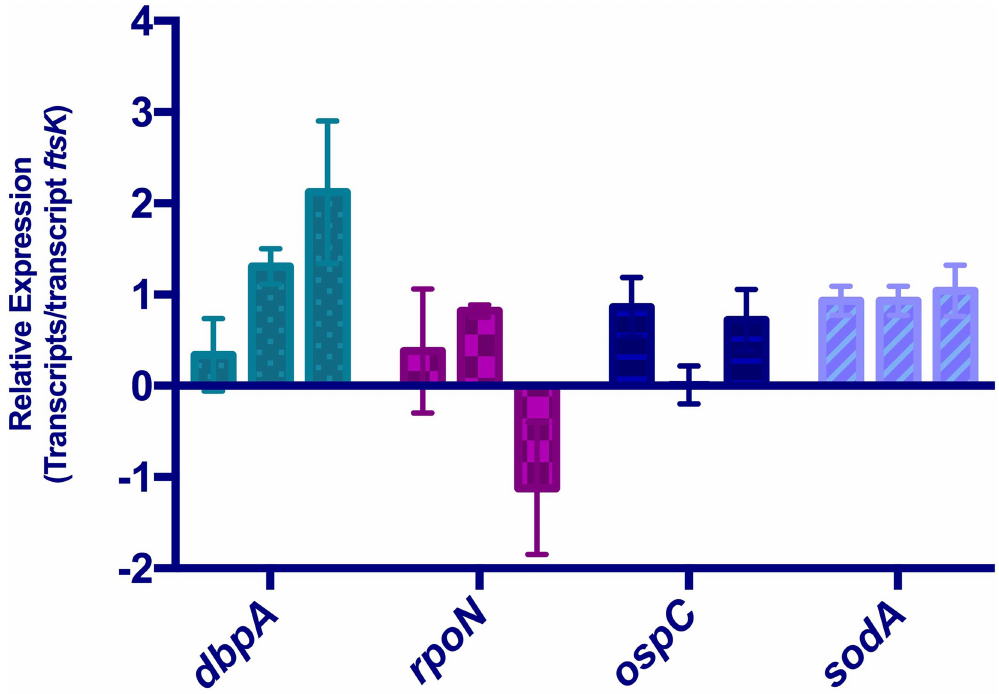
Fig 2. Quantitative RT-PCR analyses of select transcripts. Results for each transcript were compared with results for ftsK transcript of that culture. For each gene tested, bars from left to right are relative abundanceduring early-exponential, mid-exponential, and stationary phases of